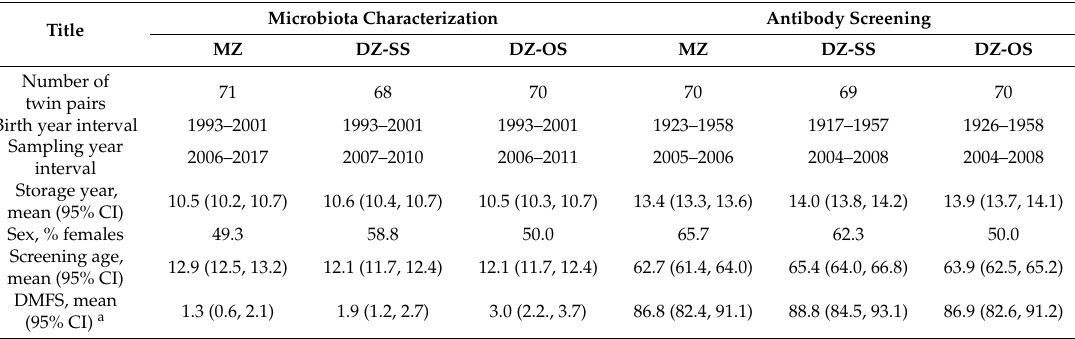
Table 1. Participant